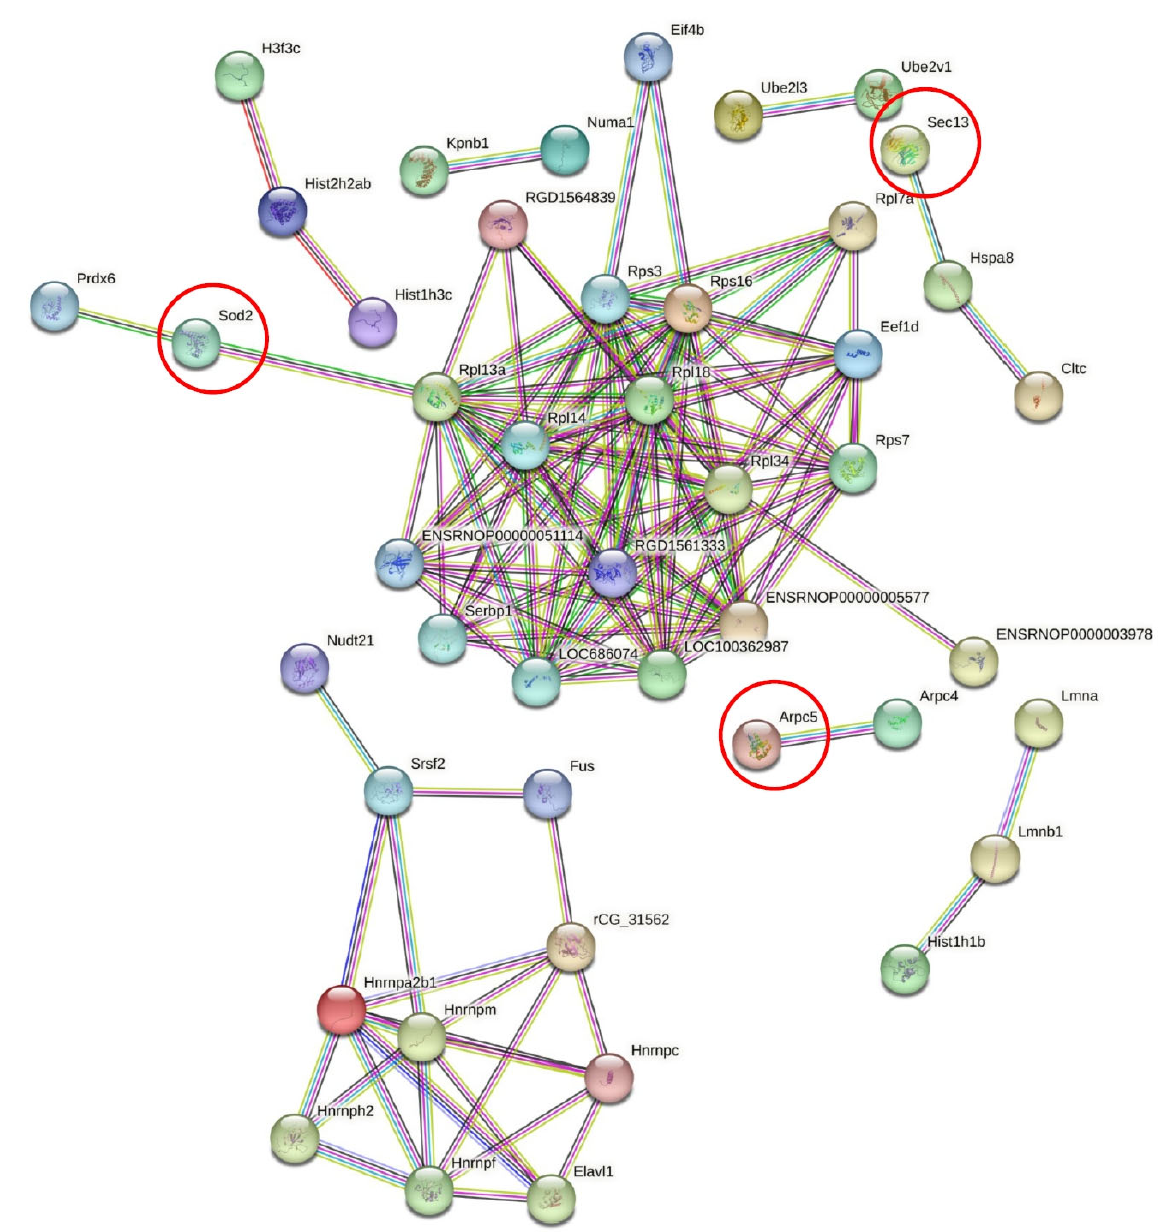
Figure 5. Protein-protein interaction network analysis (high-confidence of 0.700 with hidden disconnected nodes in the network) of the differentially abundant proteins in the PDL of the control and obese groups. Red circles represent three proteins that were more abundant in the obesity group compared to the control group: Sod2, Sec13, and Arpc5.